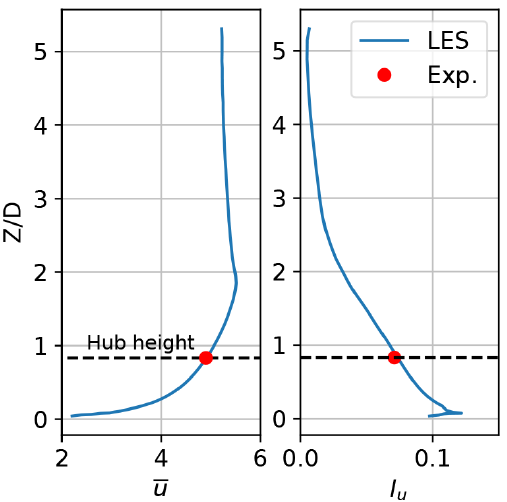
Figure 3. Vertical profiles of the streamwise mean velocity u and the streamwise turbulence intensity I u . Solid blue lines represent the LES results and red dots represent the corresponding measure- ment data at the hub